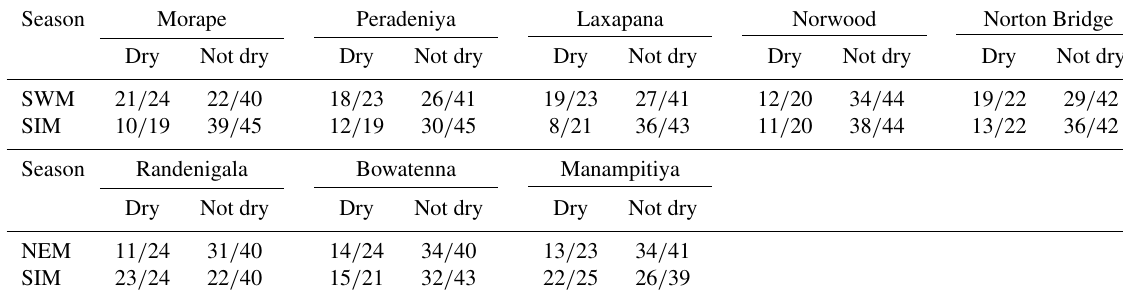
Table A6. Classification tree model results for major rainfall season in the subbasins. Season